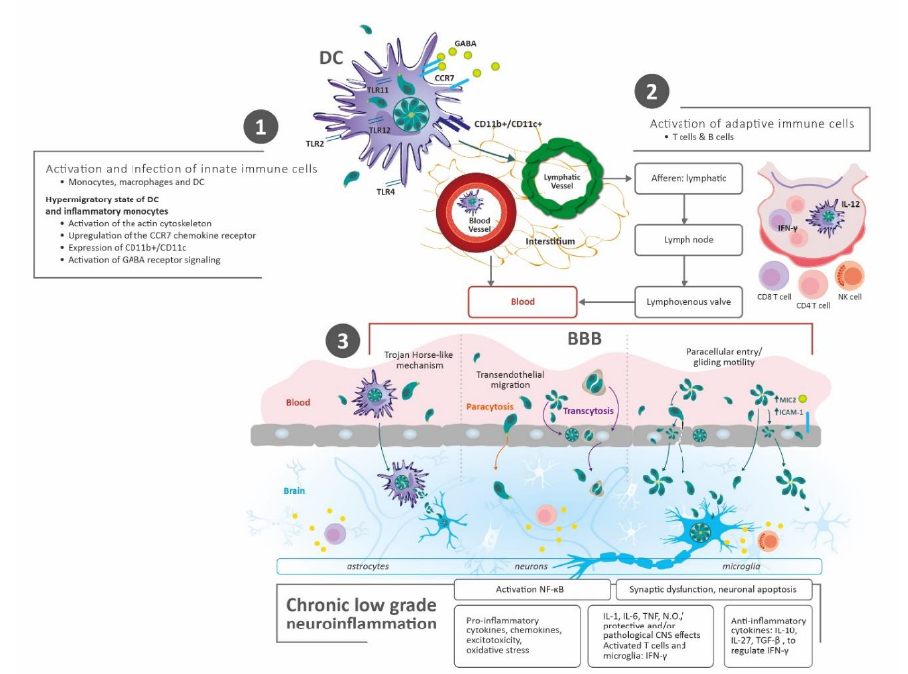
Figure 1. Parasite Transmission and Dissemination to the Brain. ( 1 ) After human infection with Toxoplasma gondii via the oral route (tissue cysts and oocysts), early immune events start in the gut tissue of the host. Innate immune cells are infected and activated, simultaneously. These cells migrate rapidly and spread hematogenously, reaching lymph nodes and peripheral tissues, such as the brain. ( 2 ) Adaptive immune cells (T and B cells) are stimulated by antigen presenting cells (i.e., dendritic cells — DC) in lymph nodes. In the same way, these inflammatory cells migrate and spread through the blood, disrupting the blood – brain barrier (BBB) and getting into the brain. ( 3 ) Mechanisms for the transfer of the parasite from the blood to the brain: I — Through infected immune cells: DC diapedesis/Trojan horse-like mechanism. Leukocytes and DC cross the BBB through the endothelial cells or via modifying tight junctions; II — Direct entry of tachyzoites/penetration of the BBB: (a) Paracytosis (through intracellular junctions), (b) Transcytosis (transportation through vesicles), (c) Paracellular entry (increase in the parasite’s microneme protein 2 (MIC2) expression/interaction with the host cell’s intercellular adhesion molecule 1 (ICAM-1), and gliding motility). Abbreviations: Blood – brain barrier (BBB); C-C chemokine receptor type 7 (CCR7); Cluster of differentiation (CD); Central Nervous System (CNS); Dendritic Cells (DC); γ -aminobutyric acid (GABA); Intercellular adhesion molecule 1 (ICAM-1); Interleukin (IL); Interferon gamma (IFN- γ); Monocyte chemoattractant protein-1 (MCP-1); Microneme protein 2 (MIC2); Natural Killer (NK); Nitric oxide (N.O); Nuclear factor kappa-light-chain-enhancer of activated B cells (NF- κB); Toll -like receptor (TLR). Transforming growth factor-beta (TGF- β); Tumor Necrosis Factor (TNF).